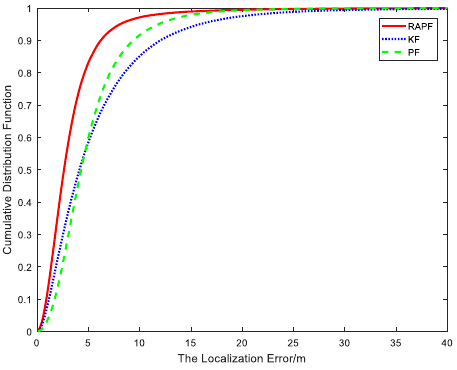
Figure 6. The cumulative distribution error of the localization error.